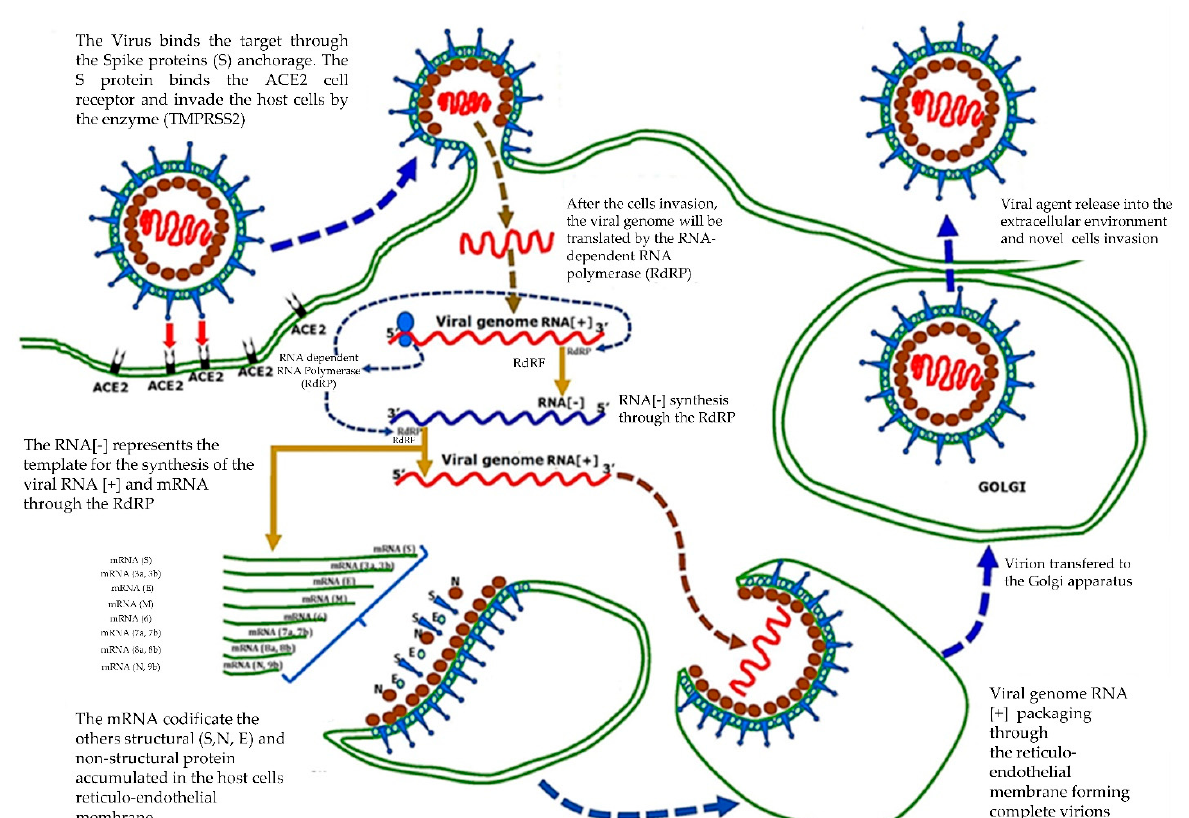
Figure 3. A rapid and sensitive diagnostic procedure for multiple detection of pandemic Coronavirus family members SARS-CoV-2, SARS-CoV, MERS-CoV, and HCoV: A translational research and cooperation between the Phan Chau Trinh Univ. in Vietnam and Univ of Bari “ A. Moro ”. June 2020. ERMPS 2020; 24: 5183–5201, doi:10.26355/eurrev_202006_21713.